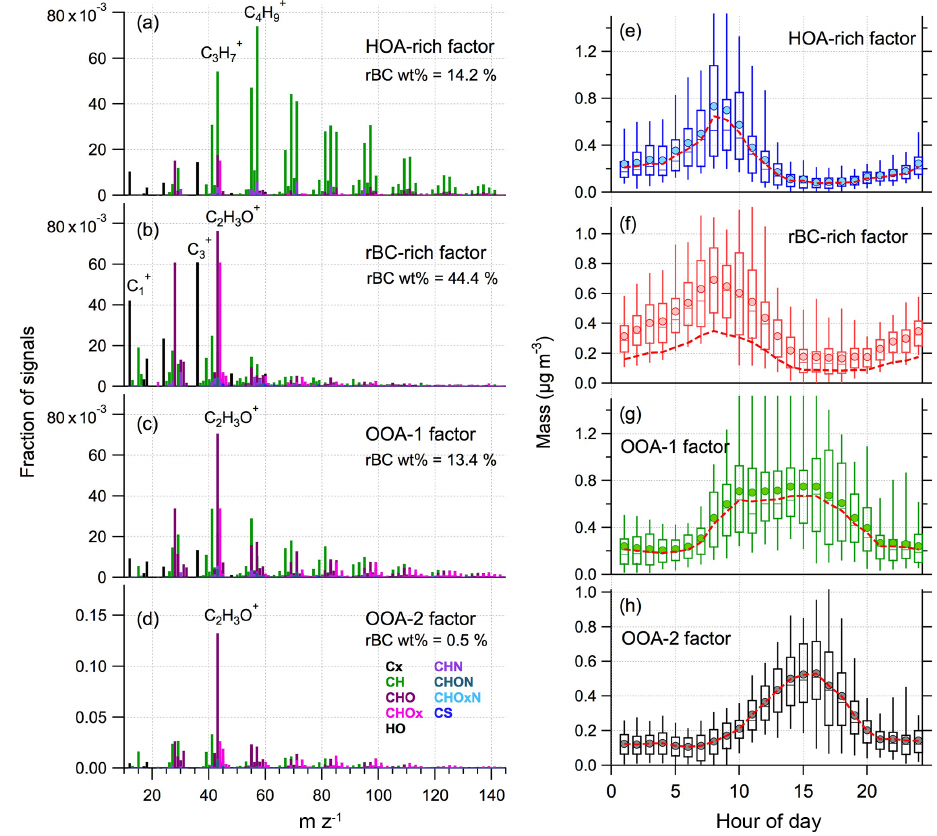
Figure 3. Mass spectra (a–d) and diurnal cycles (e–h) of PMF factors from SP-AMS data within the hot period. (Box plots: 5th, 25th, 50th, 75th, and 95th percentiles. Filled circles: mean values for organic + C + x fragments. Red dashed lines: mean values for organic alone. RIEs of 0.26 and 1.4 were applied for rBC and organic fragments, respectively, for the diurnal